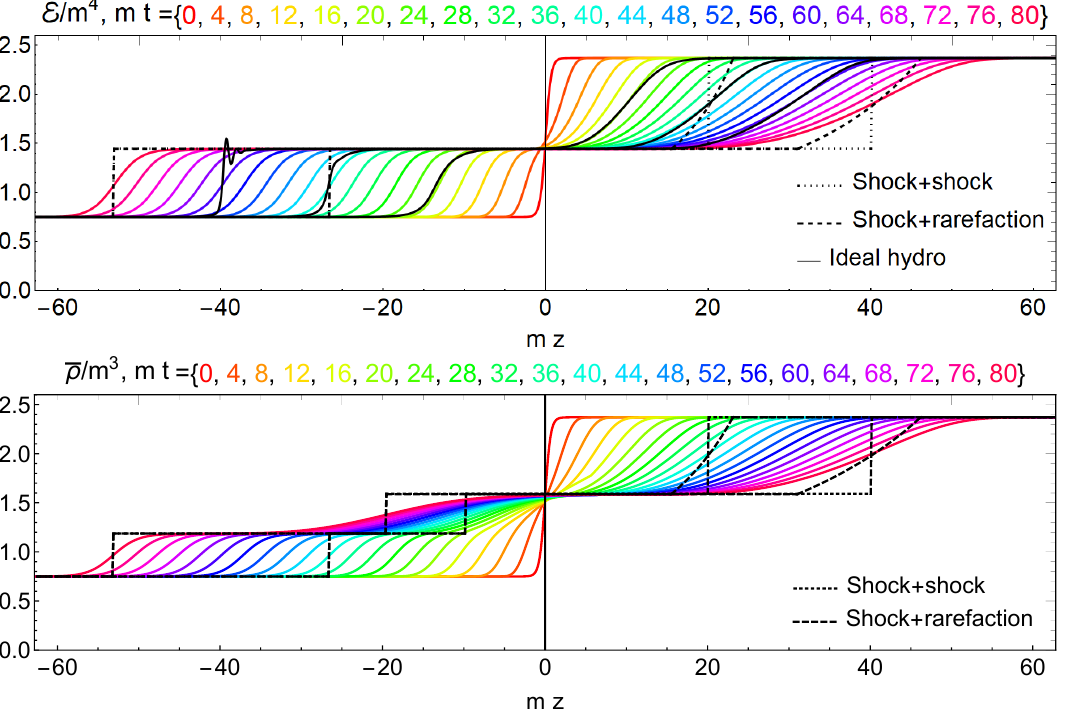
Figure 6: Evolution of the energy density (top) and charge density (bottom). Coloured lines are snapshots at various different times of the holographic simulation. For comparison we show in the upper panel results of the analytical shock + shock (black dotted, at t = 40 and 80) and shock + rarefaction (black dashed) solution as well as a numerical solution of the ideal hydrodynamics equations with smooth initial data (black solid, at t = 20,40 and